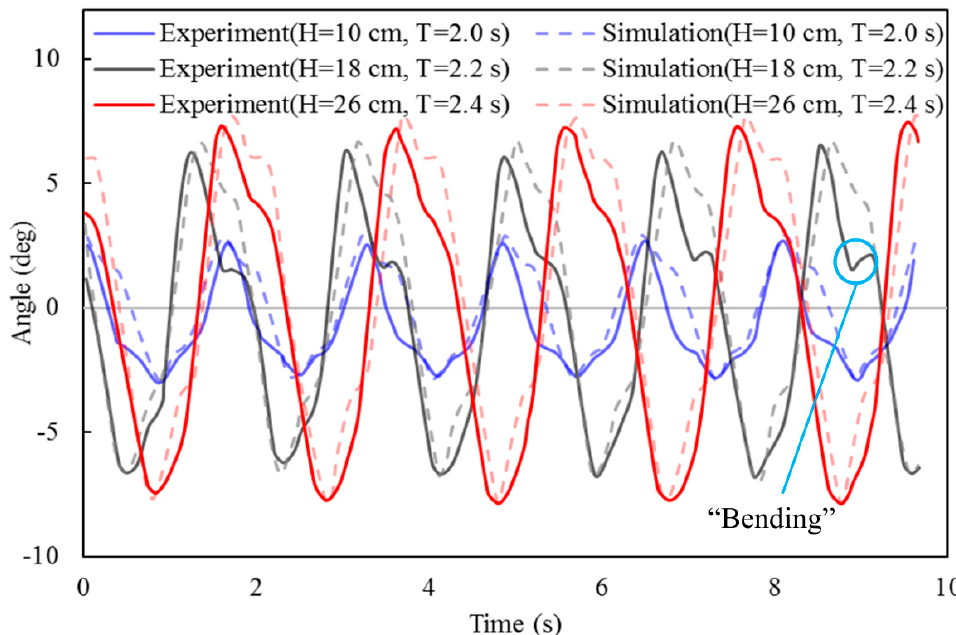
Figure 17. Experimental and simulation results of the platform angle response under different wave conditions.